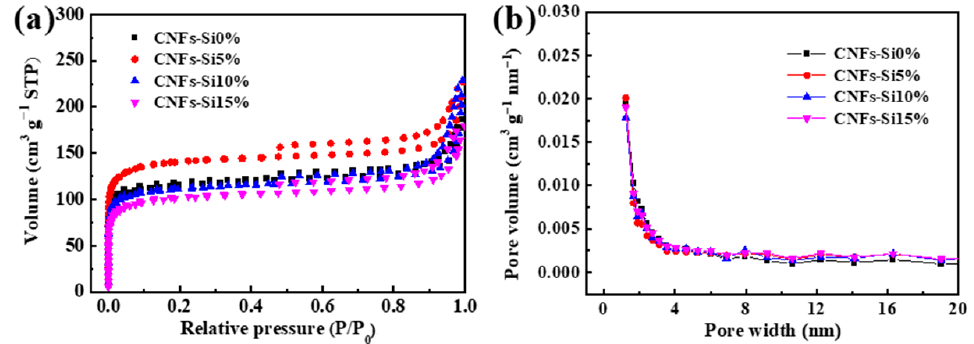
Figure 5. ( a ) Nitrogen adsorption–desorption curves, and ( b ) the corresponding pore size distribution curves of CNFs-Si0%, CNFs-Si5%, CNFs-Si10% and CNFs-Si15%.